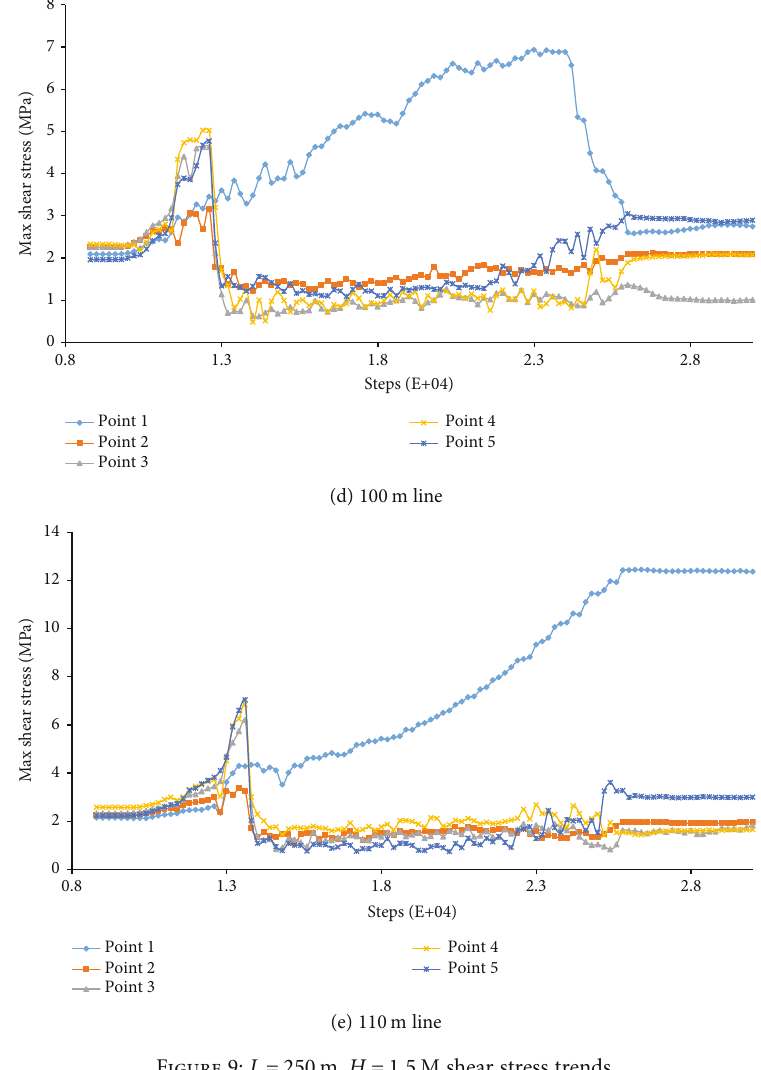
Figure 9: L = 250 m, H = 1 : 5 M shear stress trends.